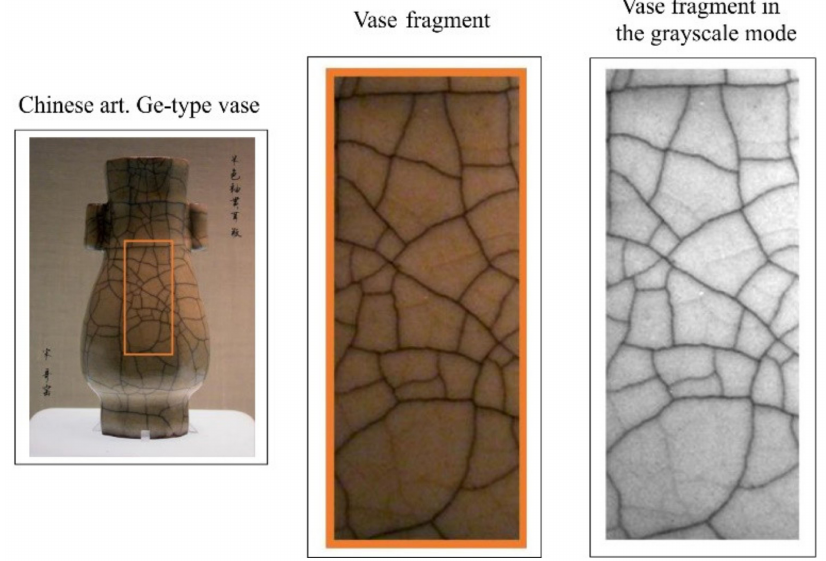
Figure 17. Craquelure on the surface of artwork. Credit: Wikipedia